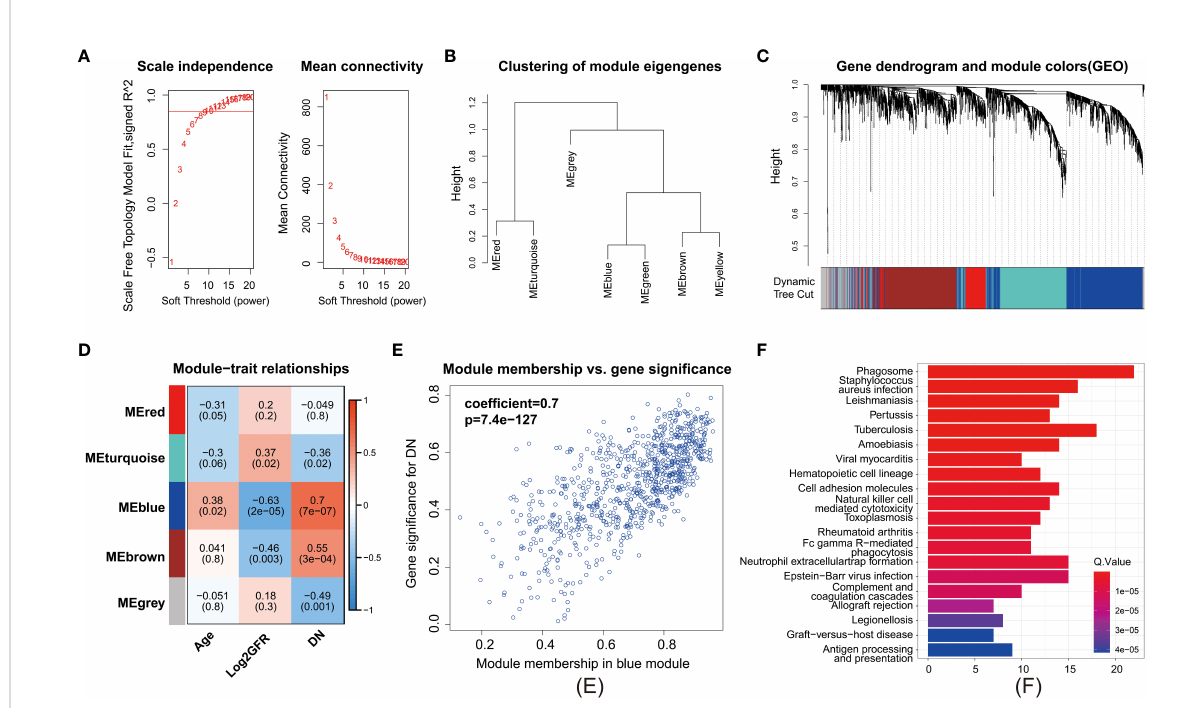
FIGURE 4 Weighted gene correlation network analysis. (A) Clustering of modules. (B) Clustering dendrogram of genes with dissimilarity based on topological overlap matrix. (C) Heatmap of the correlation between modules and clinical traits. Each row represents a module, and each column represents a trait. (D) Each cell contains the corresponding correlation and P value. Age, Log 2 GFR, and DN refer to age, logarithmic glomerular fi ltration rate, and traits of patients with DN. (E) Scatter plot of genes in the blue module. The horizonal axis represents module membership (MM). The vertical axis represents the importance of genes for DN. Pearson correlation coef fi cients of MM and gene signi fi cance and the P value are listed at the top of the plot. (F) KEGG pathway enrichment analysis of genes in the top 25% of